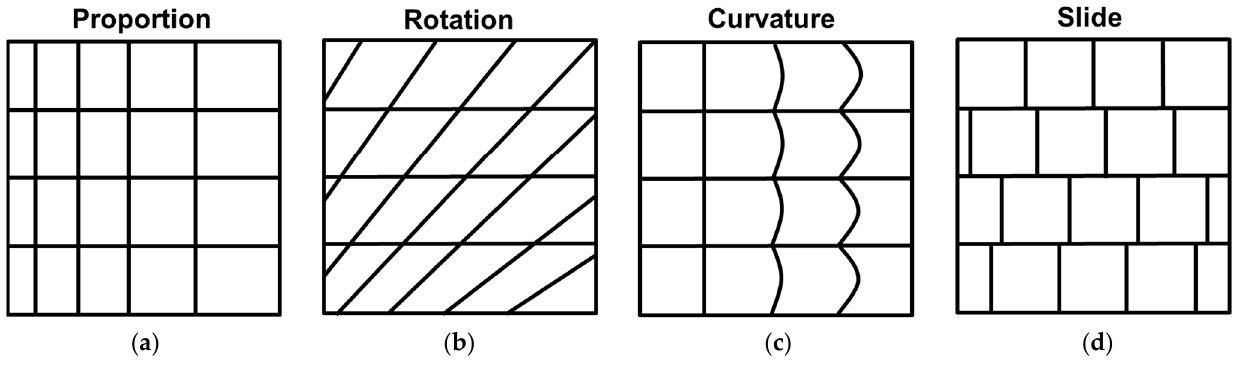
Figure 9. The four types of gradation proposed: ( a ) proportion, ( b ) rotation, ( c ) curvature, and ( d ) slide—these are applied at the level of the unit cell, with the exception of the curvature type ( c ), which is demonstrated at the level of the member.